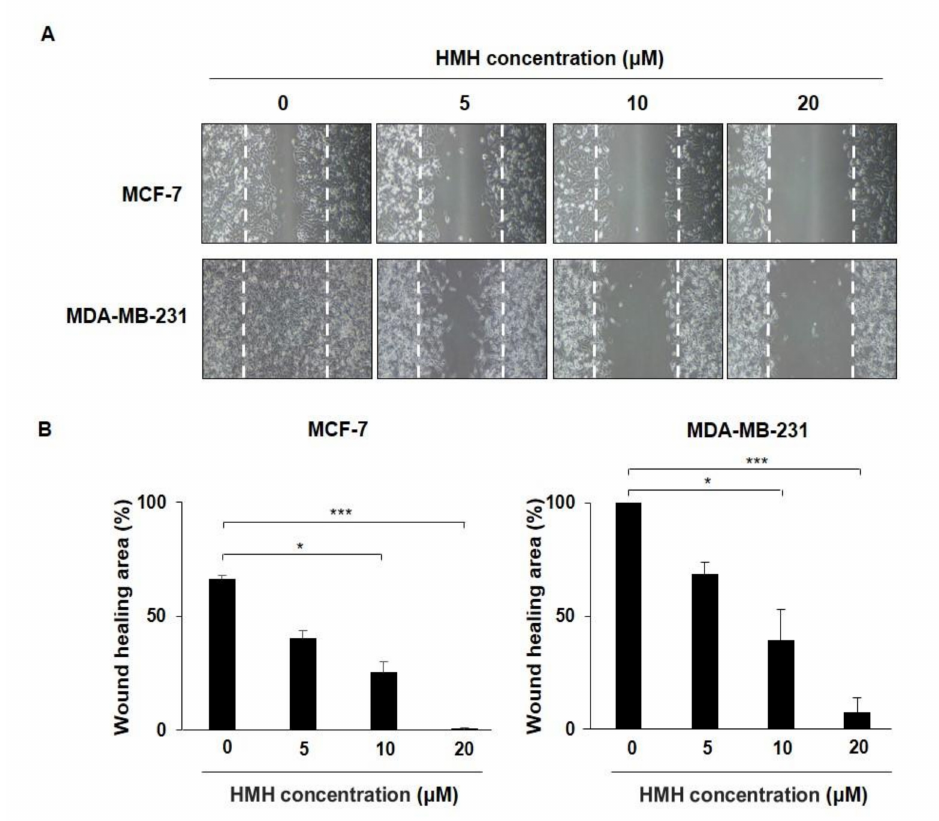
Figure 3. Effects of harmine hydrochloride on the migration of MCF-7 and MDA-MB-231 cells. ( A ) Upon confluency in six-well plates, the MCF-7 and MDA-MB-231 cells were scratch-wounded and treated with harmine hydrochloride at various concentrations in the range of 0–20 µ M to measure the migration area after 48 h. ( B ) The MCF-7 and MDA-MB-231 cells were observed with a microscope, followed by measurement of the wound area, and the percentage of the healed area has been represented after quantification using ImageJ software. Values are presented as mean ±